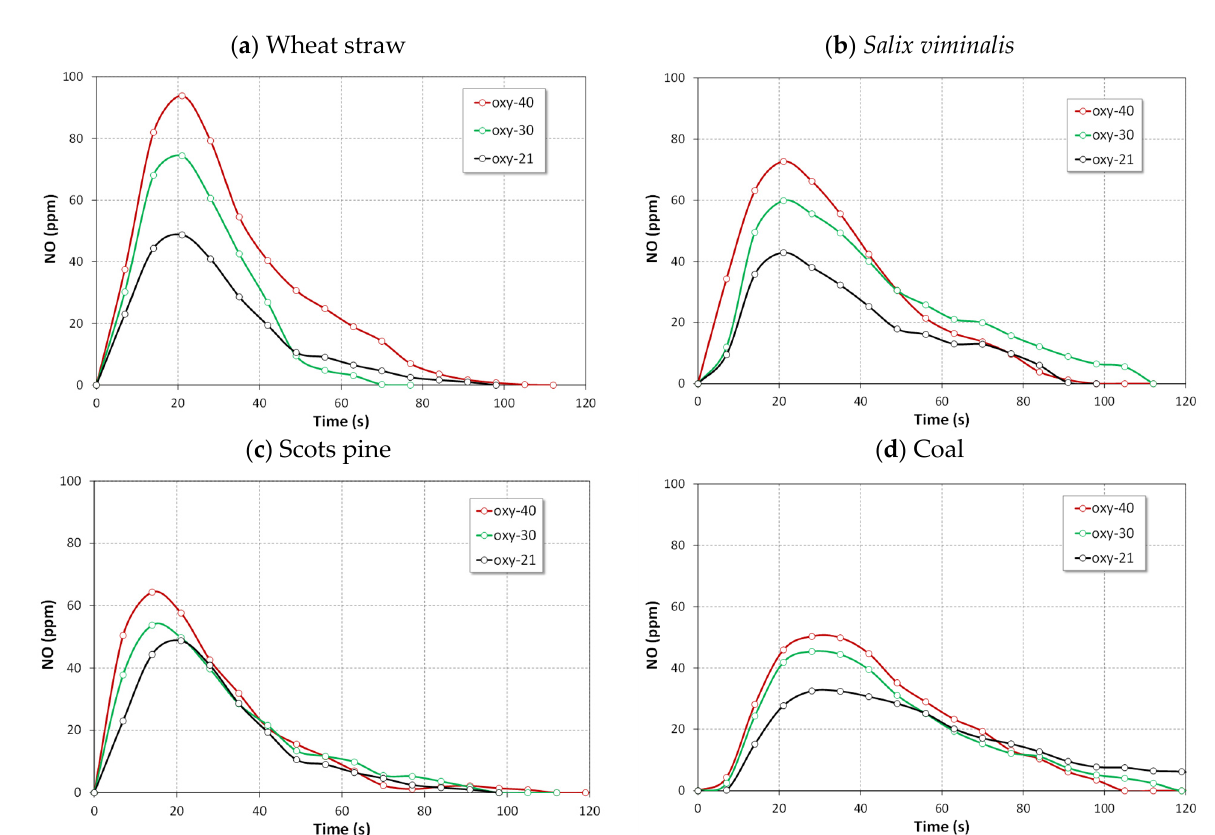
Figure 8. The instantaneous concentrations of NO during oxy-combustion of tested fuels. Emissions of N 2 O were significantly lower in comparison with NO emissions. Nitrous oxide was formed simultaneously with NO, which implies that formation of N 2 O proceeded by direct oxidation of fuel nitrogen rather than by the reduction of NO. The highest N 2 O concentrations were detected during volatile matter combustion in the oxy-21 atmosphere. The highest value of N 2 O concentration, approximately 18 ppm, was observed for the combustion of wheat straw (Figure 9a). As the oxygen concentration in O 2 /CO 2 atmosphere increased, N 2 O concentrations decreased. The lowest N 2 O emissions (below 5 ppm) were observed for oxy-combustion of Scots pine, the fuel with the lowest nitrogen content. Emissions of NO 2 were only detected during char combustion in oxy-21 atmosphere. The highest instantaneous NO 2 concentration did not exceed 6 ppm for coal and 4 ppm for wheat straw. Figure 10 shows total NO, N 2 O and NO 2 emissions during combustion in the oxy-21 atmosphere. Total emissions of NO 2 were approximately 20 ppm and 10 ppm for coal and wheat straw, respectively. This finding is consistent with the results obtained by Lasek et al.